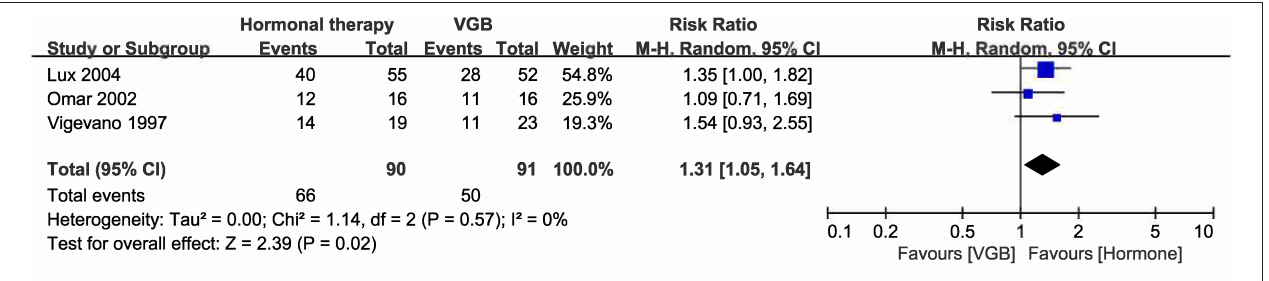
FIGURE 6 | Forest plot showing RR and 95% CI of spasm cessation between hormonal therapy and vigabatrin.